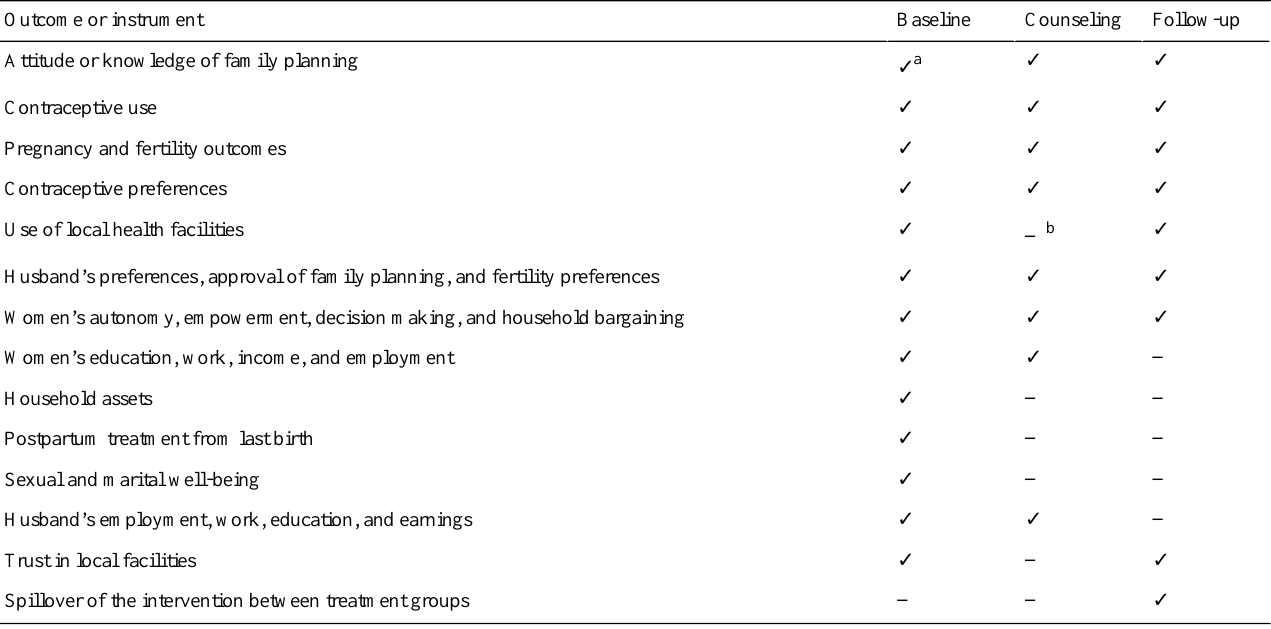
Table 3. Outcome measures and instruments. Follow-upCounselingBaselineOutcome or